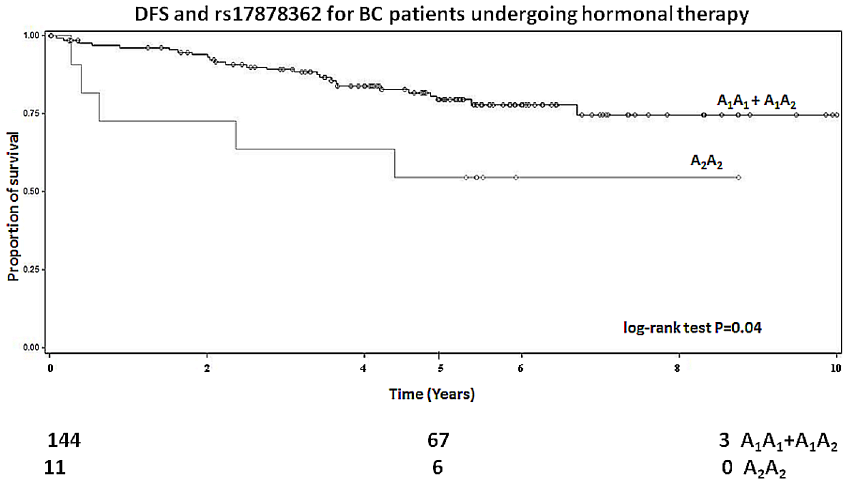
Fig 2. Kaplan-Meier disease-free survival curves for TP53 rs17878362 polymorphism in patients receiving only the hormonal therapy (log-rank for recessive model). Numbers of patients at risk are indicated in the lower part of the